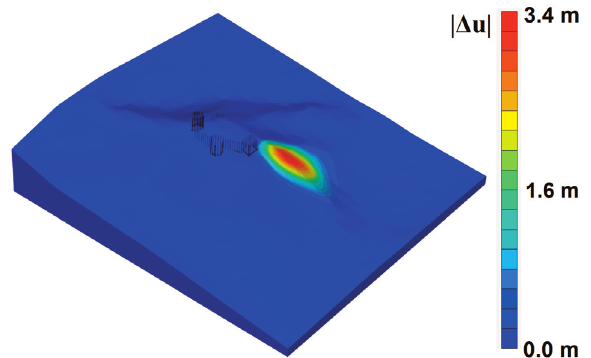
Fig. 7. Slope stability of colluvial material visualized through shadings of the total displacement increments (| Δ u|).